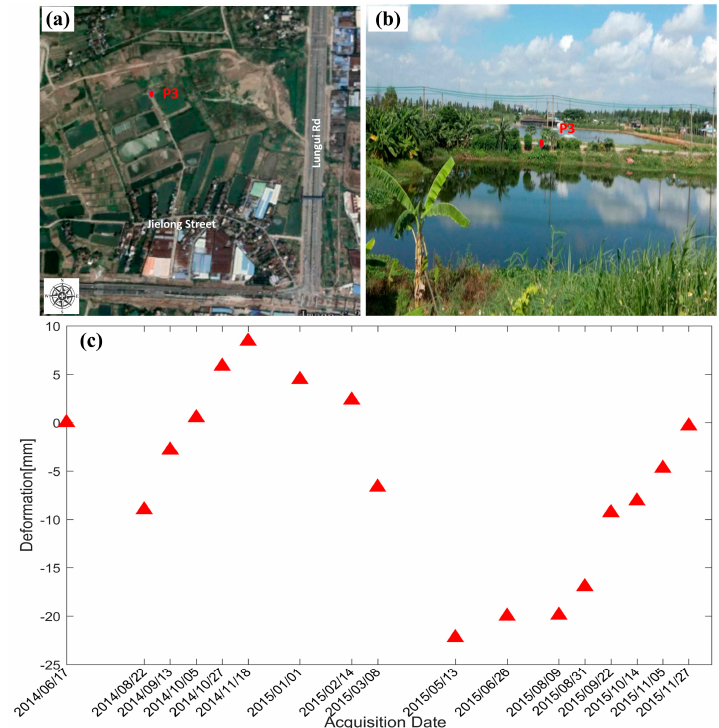
Figure 22. Time series deformation on point P2 (referenced to 2014/06/17): ( a ) corresponding location on google earth satellite image; ( b ) in situ pictures of P2; ( c ) time series deformation evolution on P2.